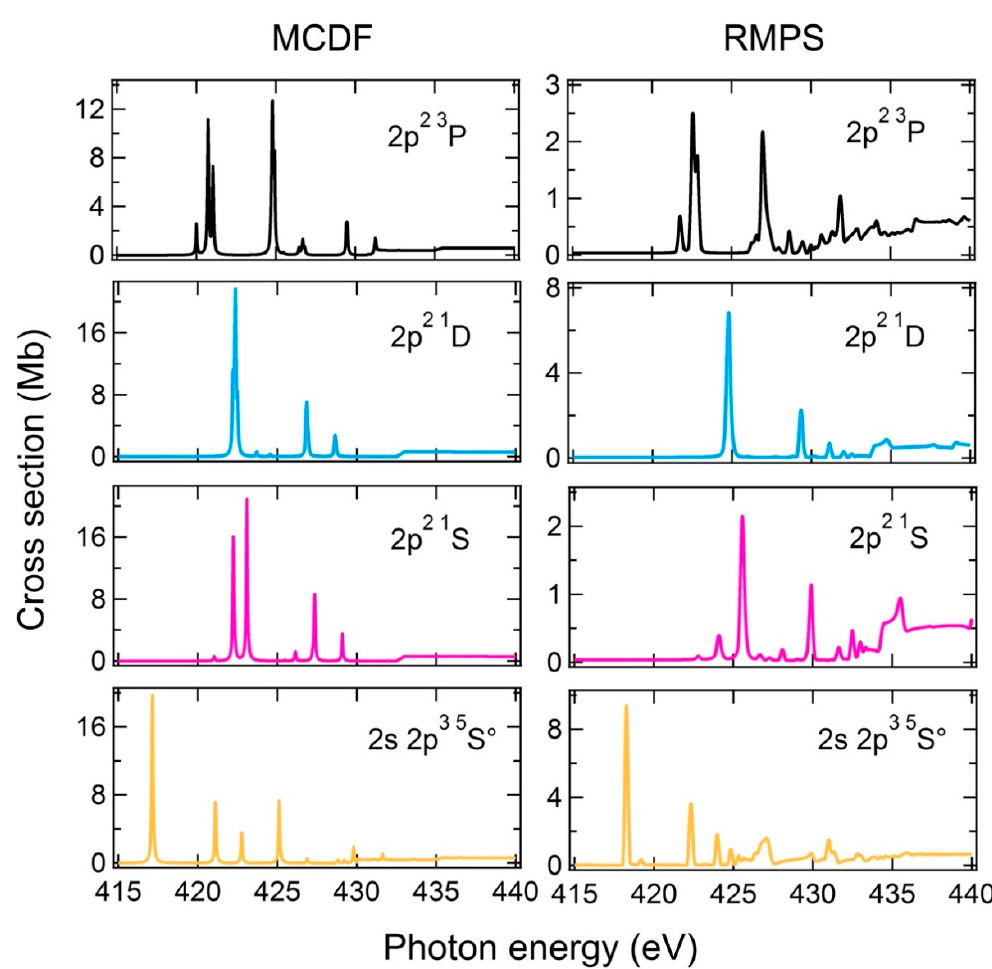
Figure 5. Multiconfiguration Dirac-Fock (MCDF) and R-Matrix with pseudo-states (RMPS) theoretical calculations of the 1 s −→ np , n ≥ 3 photoexcitation and 2 p photoionization cross sections from the 3 P , 1 D , 1 S and 5 S states of the 1 s 2 2 s 2 p 2 ground and 1 s 2 2 s 2 p 3 excited configurations of N + ,